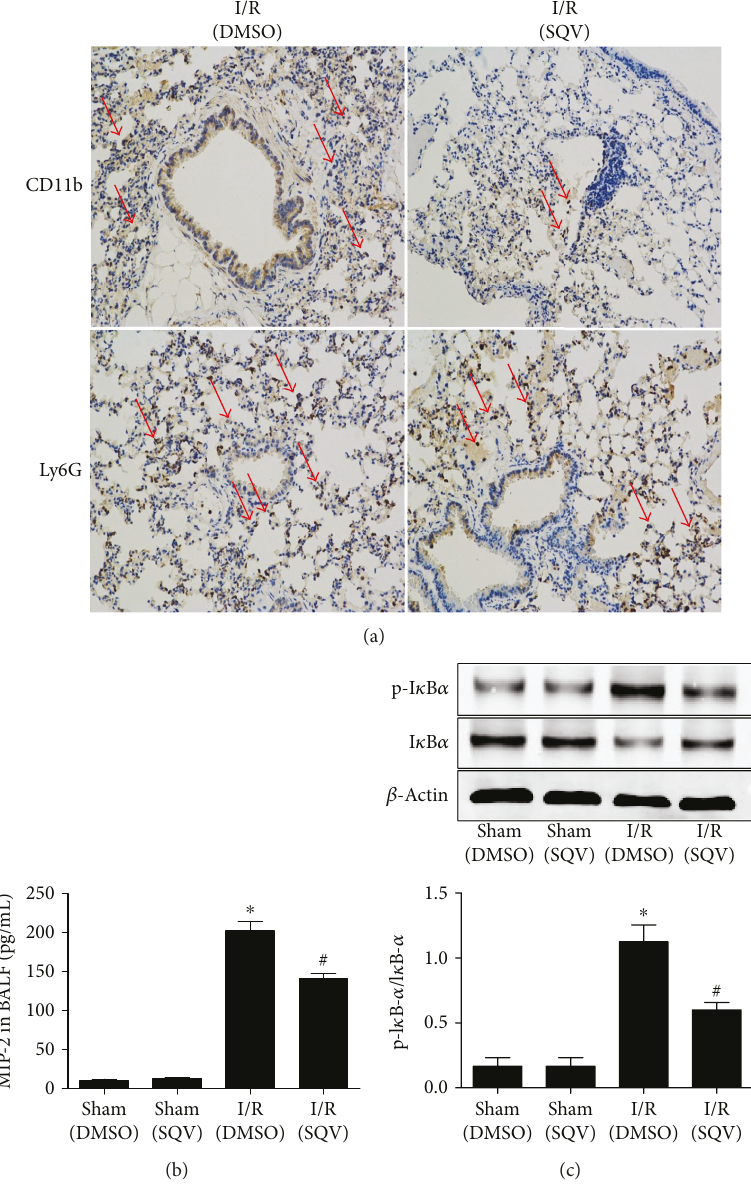
Figure 3: SQV regulates macrophages in the lung after liver I/R. IHC was used to stain either macrophages (CD11b + ) or neutrophils (Ly6G + ) in the lung tissue after SQV treatment (a). As well, the MIP-2 levels in BALF were tested by ELISA (b). I κ B α and p-I κ B α activation of local lung tissue from all groups was assessed by Western blot (c). GraphPad values are presented as mean ± SEM. ∗ P < 0 05 versus the Sham group; # P < 0 05 compared to the liver warm I/R